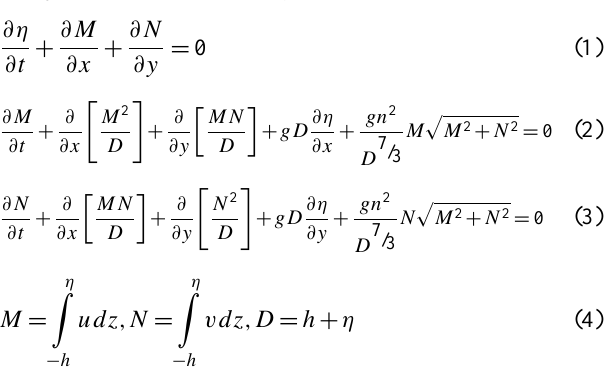
Fig. 3. Digital Terrain Model for topographic data in